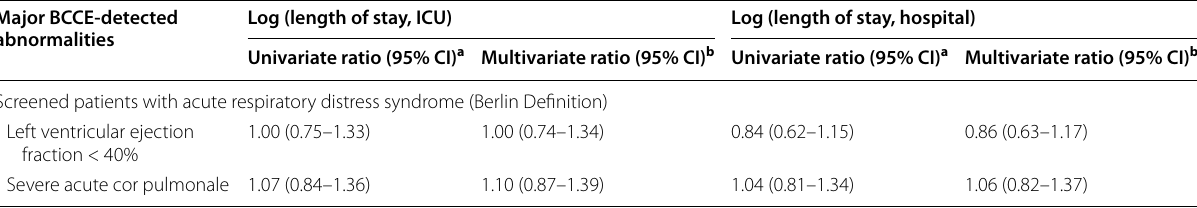
BCCE Basic critical care echocardiography, CI Confidence interval, ICU Intensive care unit a Exponentiated coefficient (with 95% confidence interval) derived using linear regression on the log-transformed LOS, unadjusted b Exponentiated coefficient (with 95% confidence interval) derived using multiple linear regression on the log-transformed LOS, adjusted for age and Acute Physiology and Chronic Health Evaluation II score